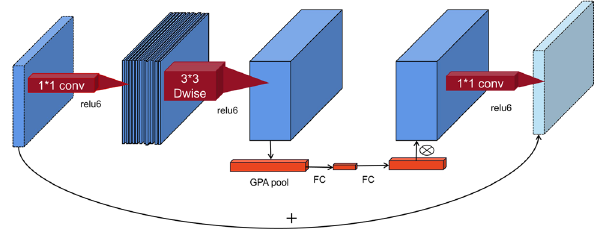
Fig. 7 This is a bottleneck, from this picture when the Dwise deals with conv using ECA and not changes the conv block